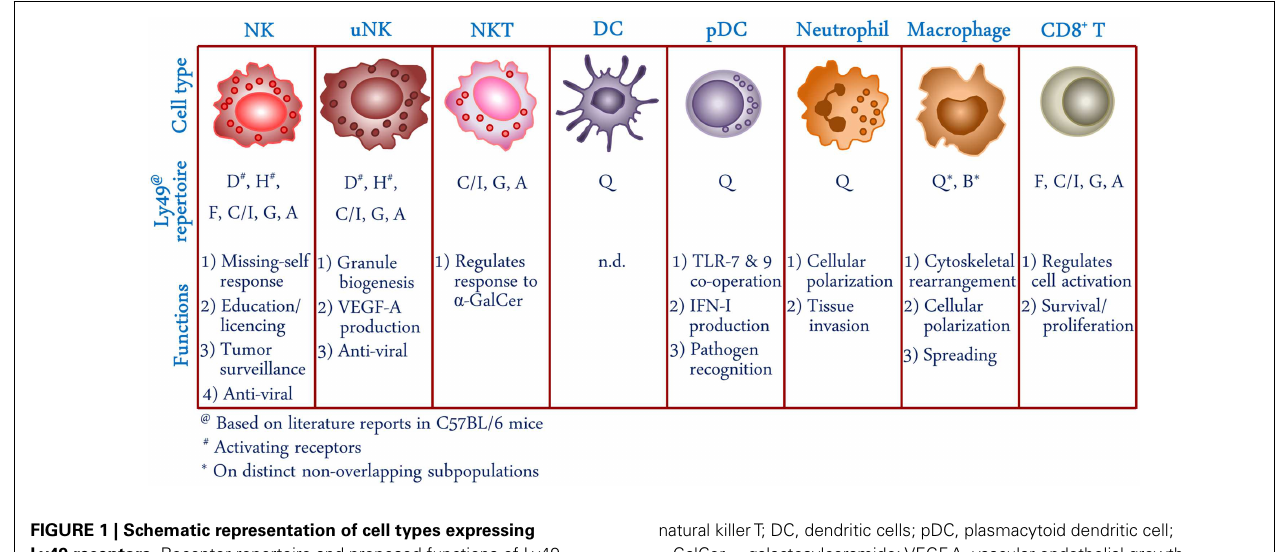
FIGURE 1 | Schematic representation of cell types expressing Ly49 receptors . Receptor repertoire and proposed functions of Ly49 in different cellular subsets is shown based on literature reports in C57BL/6 mice. NK, natural killer; uNK, uterine natural killer; NKT,